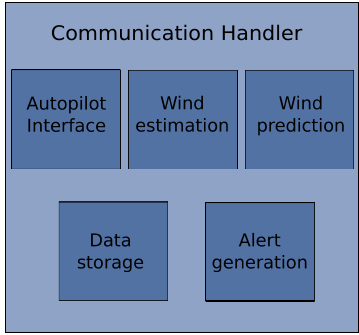
Figure 6. Architecture design with communications